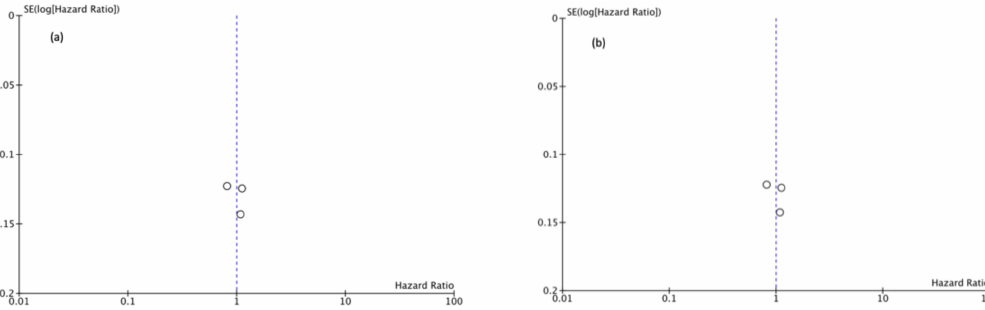
Figure 7. ( a ) Funnel Plot OS 5y, ( b ) Funnel Plot OS 10y.